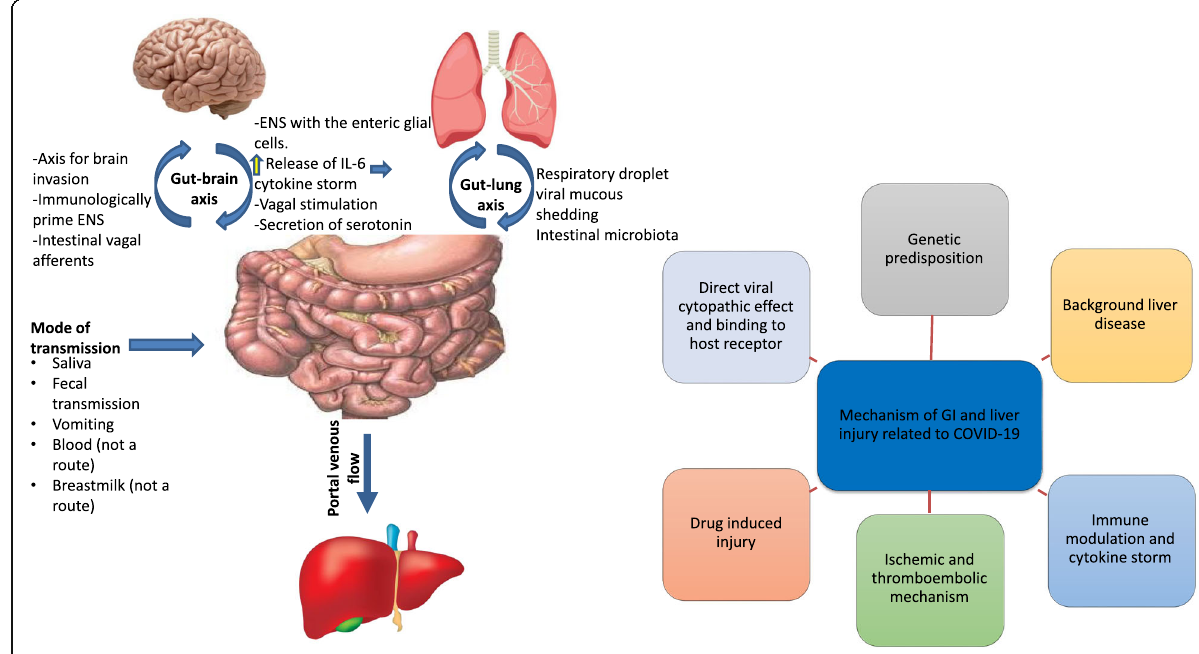
Fig. 1 The route of spread and mechanism of SARS-CoV-2-induced gastrointestinal and liver injury. ENS, enteric nervous system; IL-6,